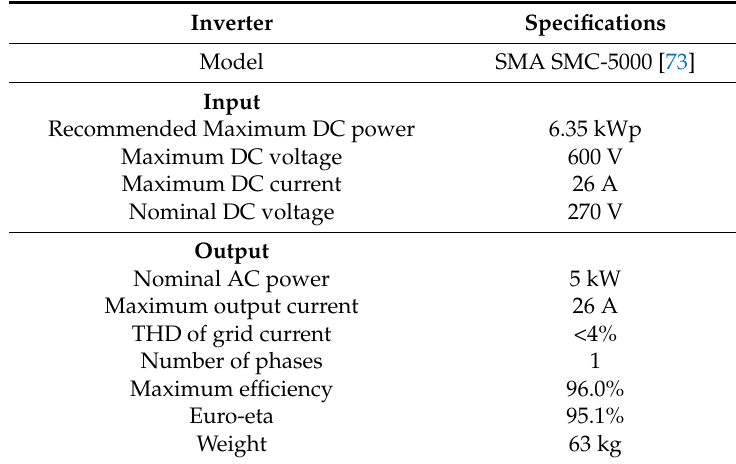
Table 3. Inverter specifications.